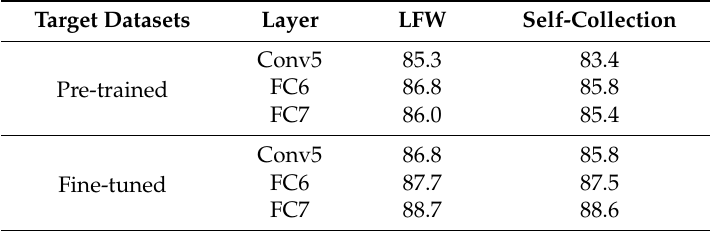
Table 1. Comparison between pre-trained convolution neural network (CNN) and fine-tuned CNN for the proposed method. LFW—Labeled Faces in the Wild; Conv—convolution layer; FC—fully connected layer.